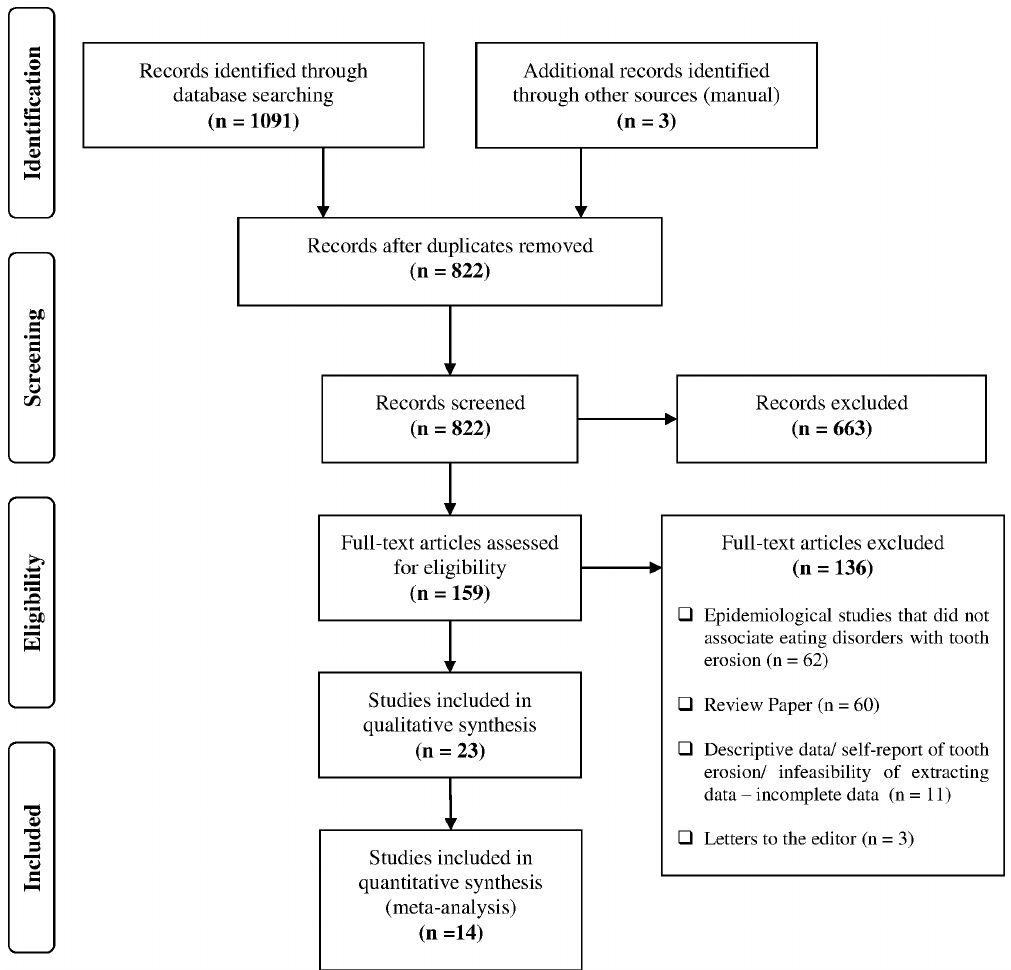
Figure 1. Screening of articles. Four-phase PRISMA flow-diagram for study collection [38], showing the number of studies identified, screened, eligible, and included in the review and meta-analysis.